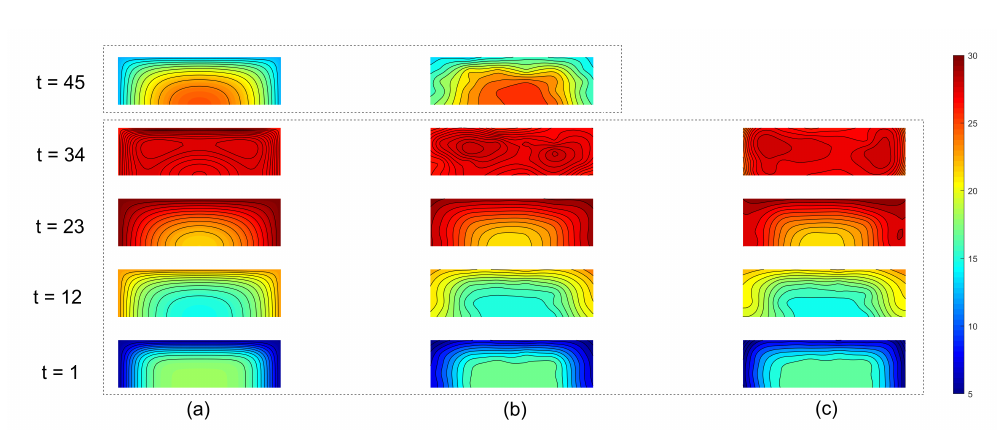
Figure 6. 2D sequence temperature simulation (times 1, 12, 23, 34 and 45 are shown): ( a ) Temperature simulation; ( b ) Fit by FUKSS; and ( c ) Fit by radial basis